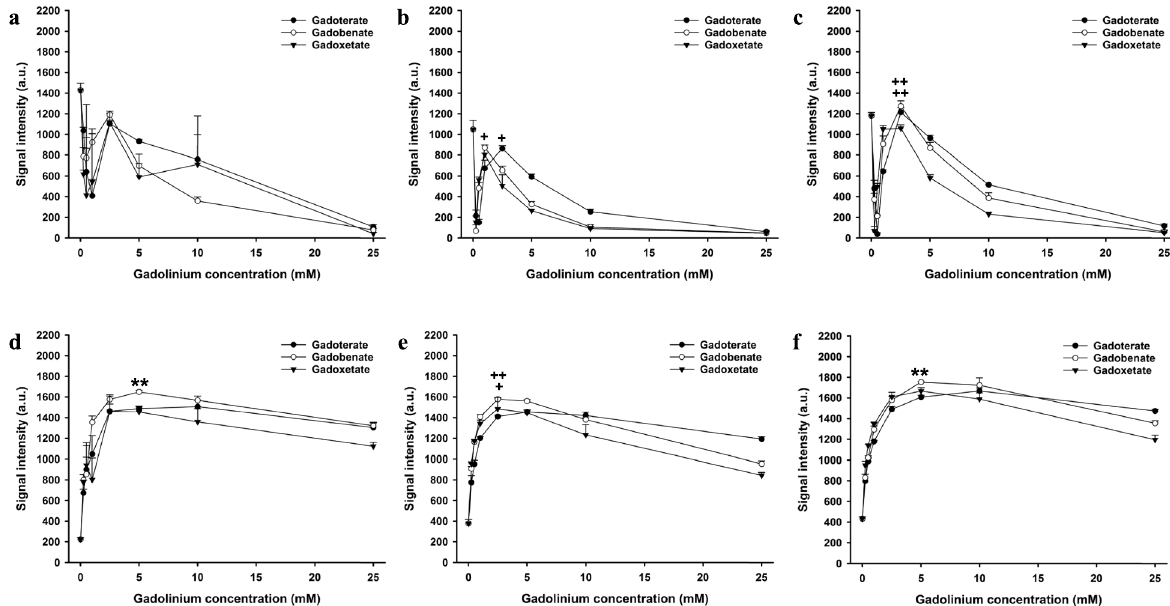
Fig. 4 Signal intensities of gadoterate, gadobenate, and gadoxetate in saline and biological fluids on short tau inversion‑recovery (STIR) and T1‑weighted high‑resolution isotropic volume excitation (eTHRIVE) sequences. Signal intensities of gadoterate, gadobenate, and gadoxetate at different concentrations in saline ( a ), blood ( b ), and bile ( c ) on STIR sequence. Signal intensities of gadoterate, gadobenate, and gadoxetate at different concentrations in saline ( d ), blood ( e ), and bile ( f ) on e‑THRIVE sequence. * significantly higher maximum signal intensity of the contrast = agent than both other contrast agents; significantly higher maximum signal intensity than the contrast agent with the lowest maximum signal + = intensity. * or p < 0.050, ** or p < 0.010; *** or p < 0.001 + = + + = + + + =